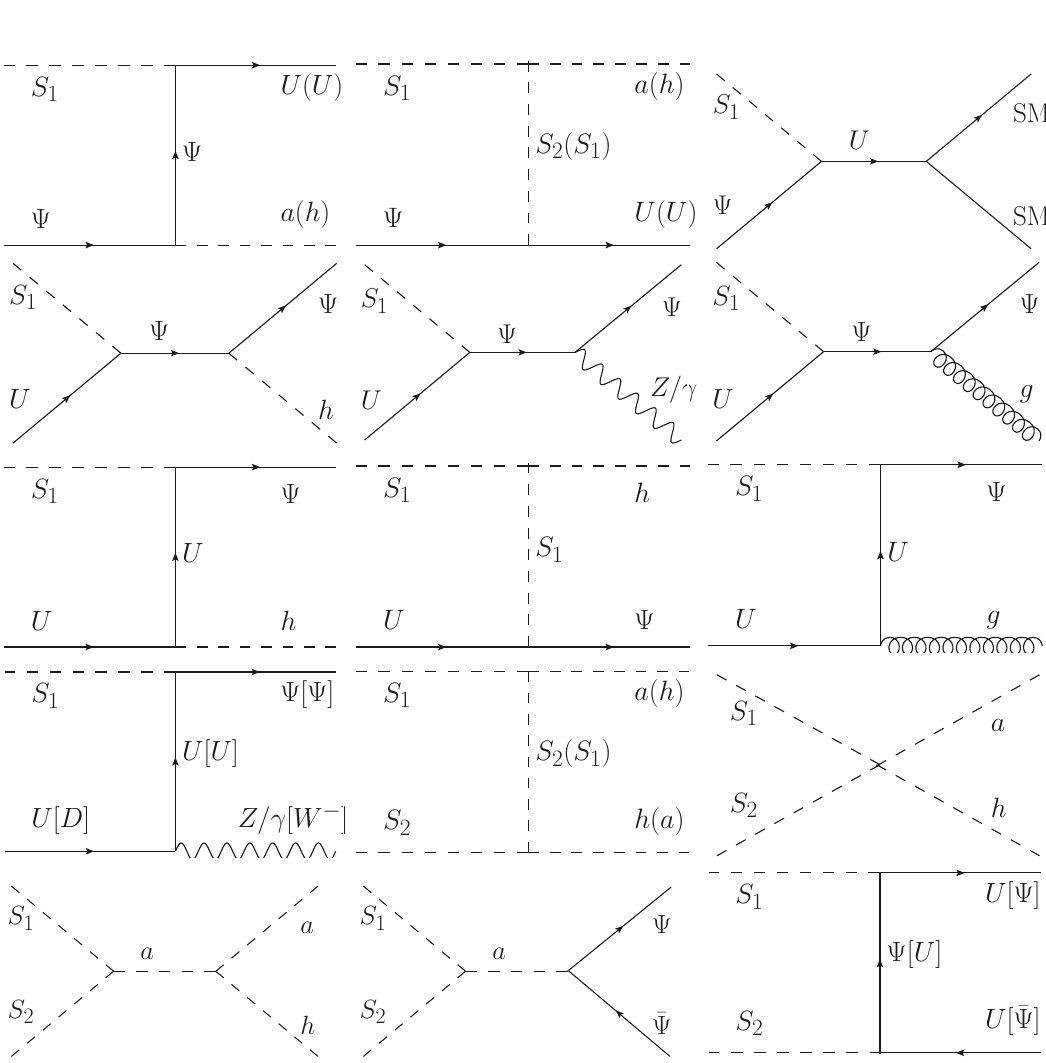
Figure 12. Co-annihilation channels of scalar dark matter S 1 . U and D denote the SM up-type and down-type quark, respectively; U ≡ u, c, t, ¯ u, ¯ c, ¯ t , D ≡ d, s, b, ¯ d, ¯ s, ¯ b